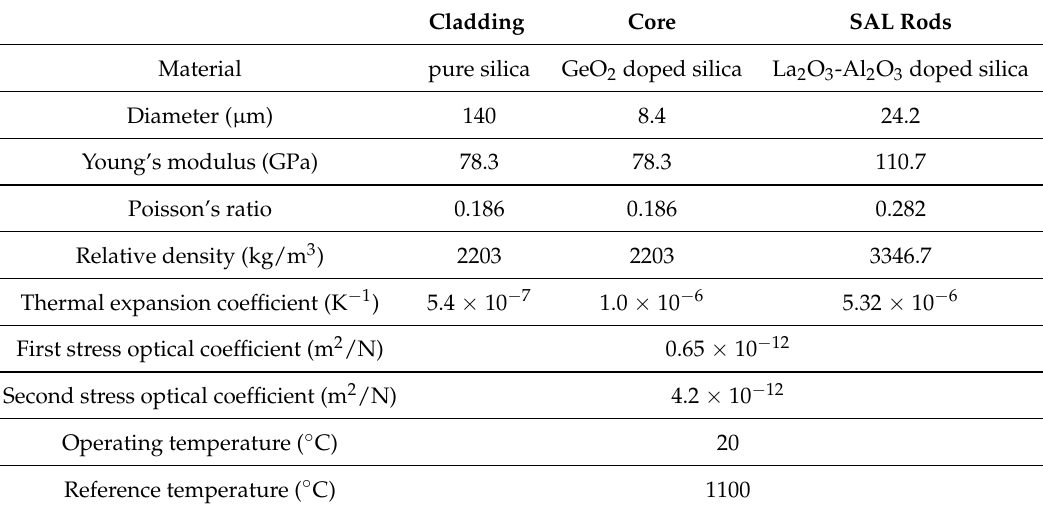
Table 1. Structure and material parameters used in the simulation